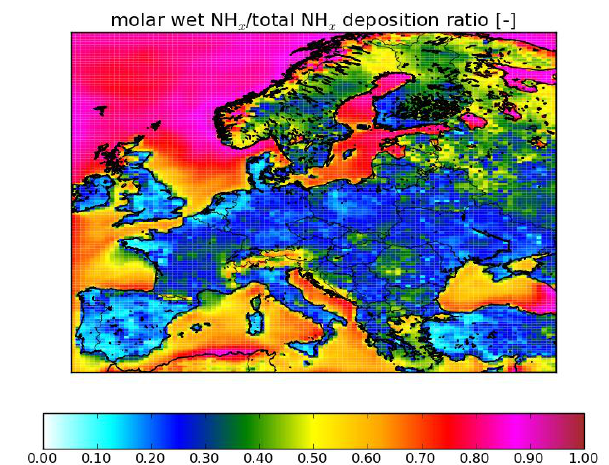
Fig. 6. Relative contribution of the wet NH x deposition to the total Figure 6. Relative contribution of the wet NHx deposition to the total NHx deposition with the NHx deposition with the DEPACold module over Europe in 2007. 'DEPACold' module over Europe in 2007. The grid resolution in these figures is 0.50° longitude x The grid resolution in these figures is 0.50 ◦ longitude × 0.25 ◦ lati- 0.25° latitude (~28x28 km 2 ). tude ( ∼ 28 × 28km 2 )